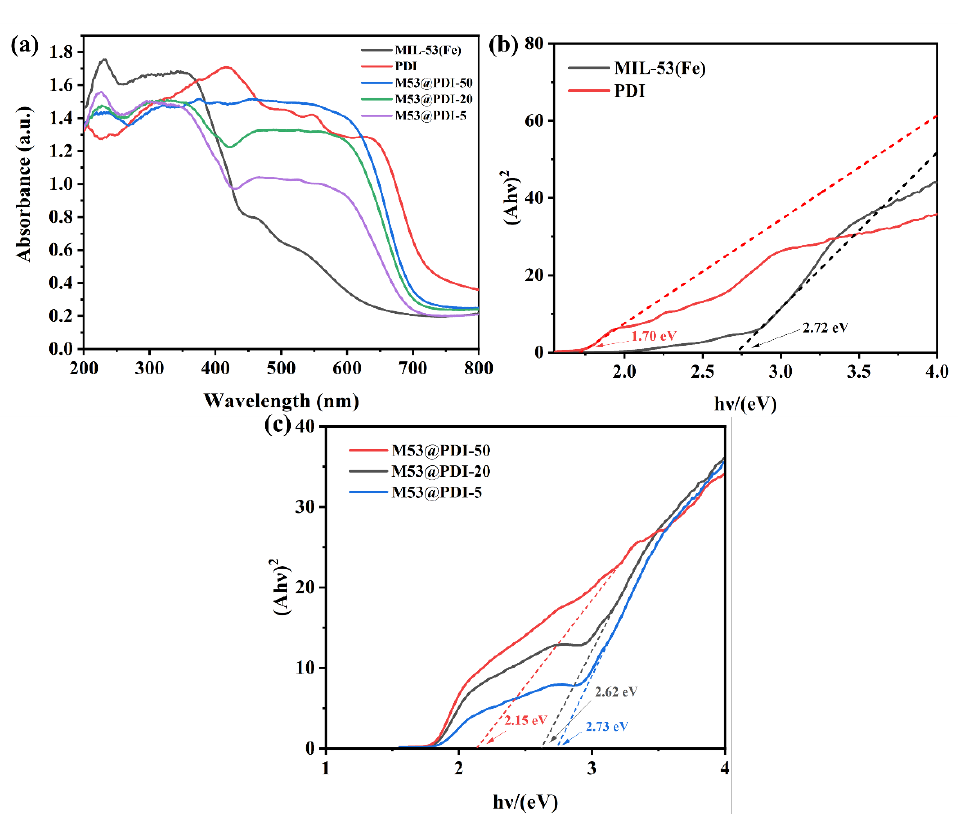
Figure 4. ( a ) UV – Vis diffuse reflectance spectra; ( b ) Tauc plots of MIL-53(Fe), PDI, and MIL- 53(Fe)@PDI heterojunctions; and ( c ) Tauc plots of